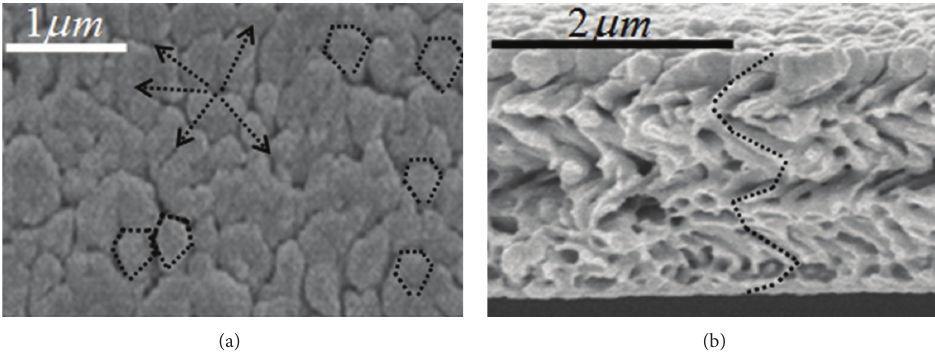
Figure 1: FESEM images of silver chiral pentagon sculptured thin film; (a) surface, (b) cross-section.